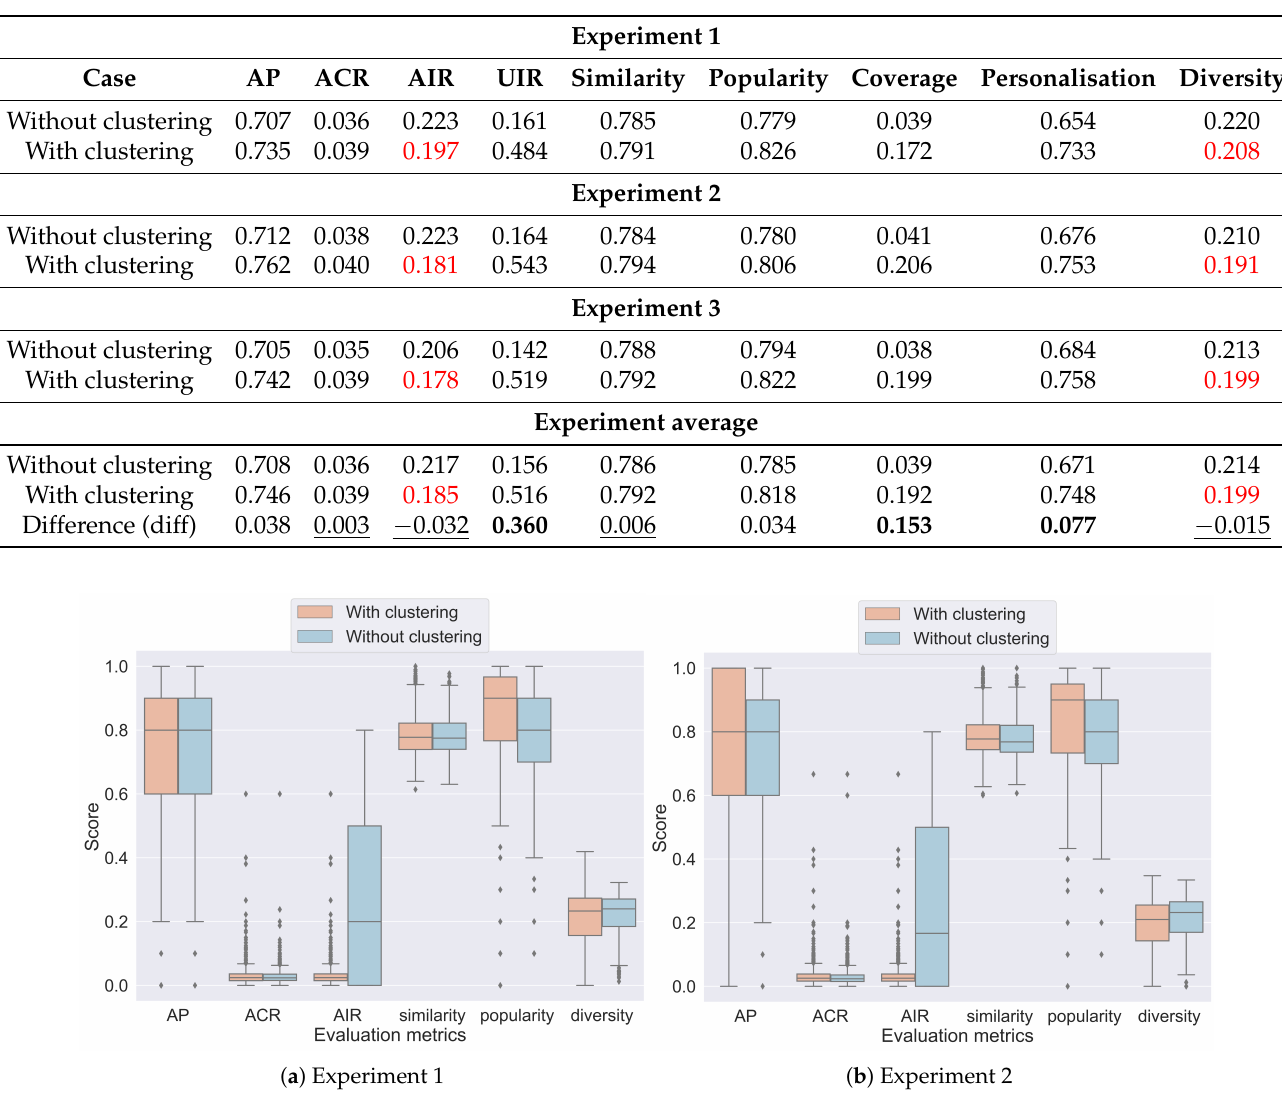
Table 6. Results of evaluation when with clustering and without.